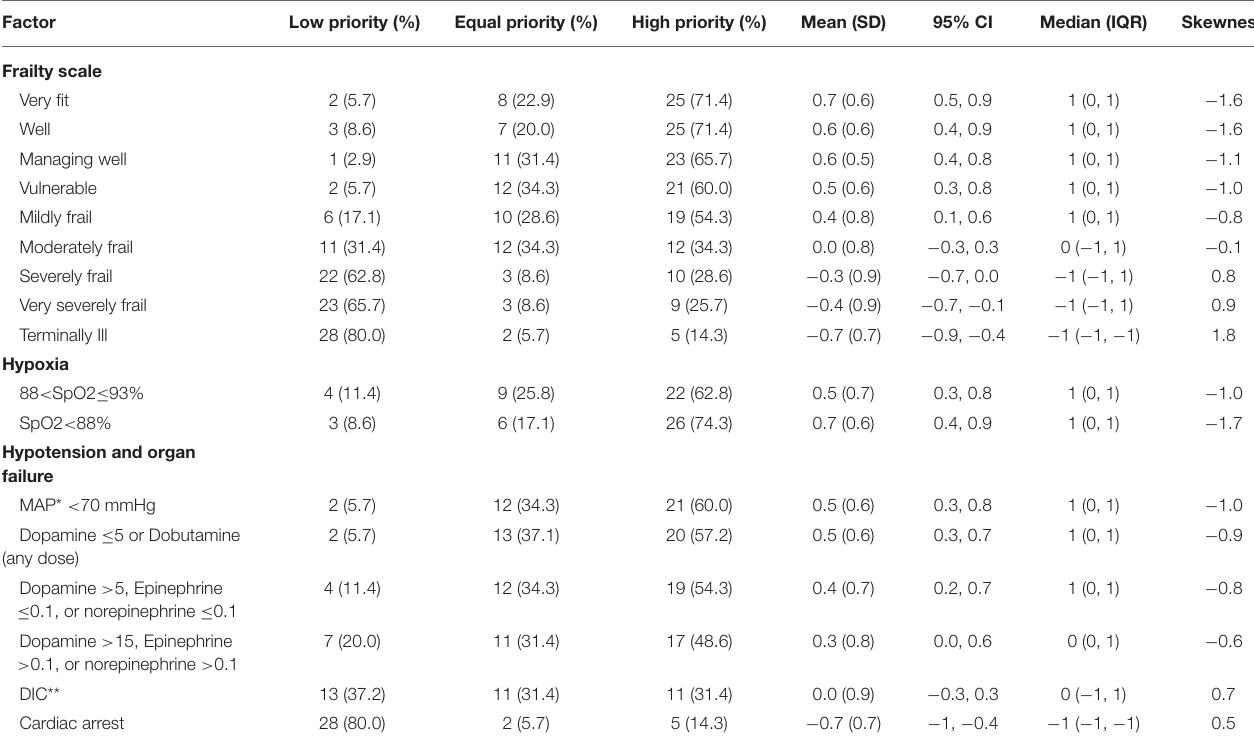
TABLE 4 | Responses on prioritising ventilator allocation regarding clinical presentation of COVID-19.